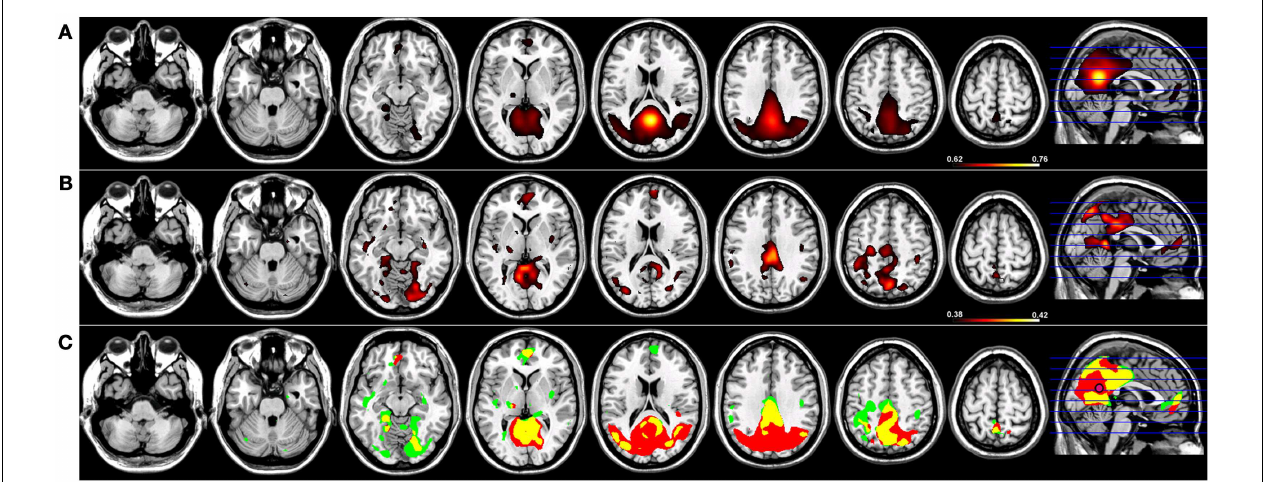
coherence (ICoh). (C) Spatial conjunction of Coh maps (in red) and ICoh maps (in green) for the DMN and overlap between the two maps (in yellow). All maps are thresholded and superimposed over the MNI template brain using MRICron.